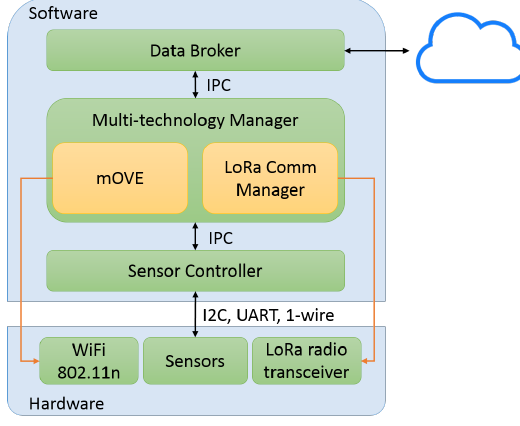
Figure 4. Gateway software